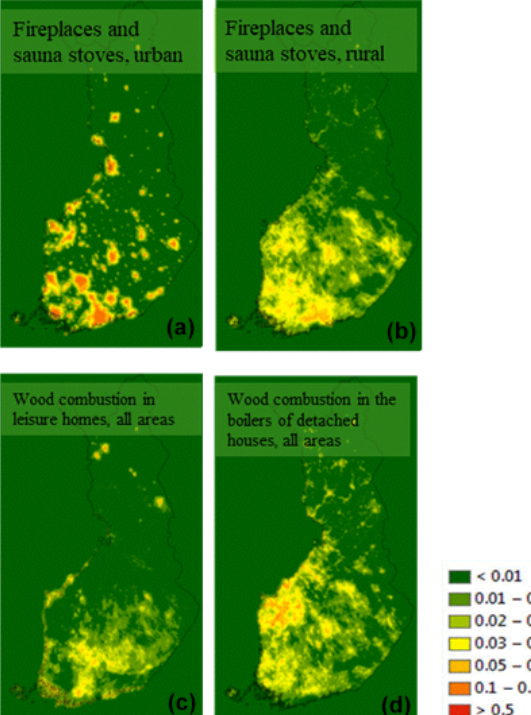
Figure 3. The reductions in concentrations of PM 2 . 5 (ngm − 3 ), caused by a reduction in emissions of PM 2 . 5 by 1t that originated from small-scale residential combustion. The changes due to the emissions in fireplaces and sauna stoves are presented in (a, b) , and the changes due to the emissions in holiday houses and in the boilers of detached houses are presented in (c, d) . For both source categories, the changes in urban and non-urban areas are presented separately, in (a, c) and (b, d) , respectively. The spatial resolution is 250 × 250m 2